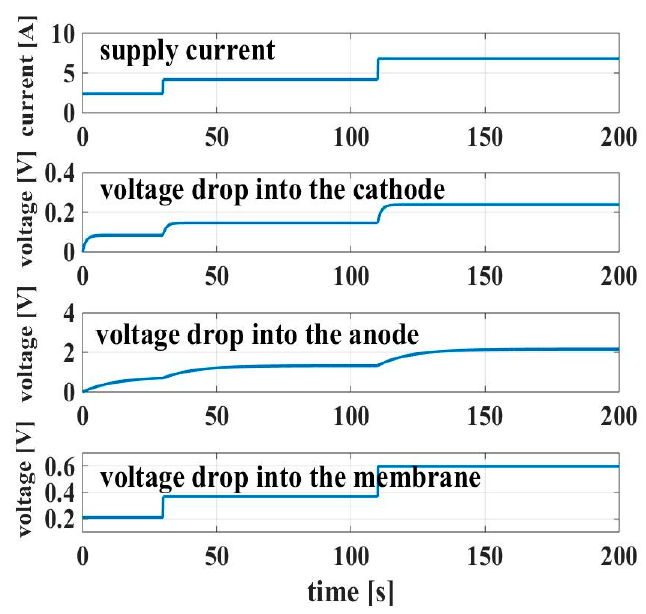
Figure 15. Voltage drop into the cathode, into the anode and into the membrane together with the supply current.